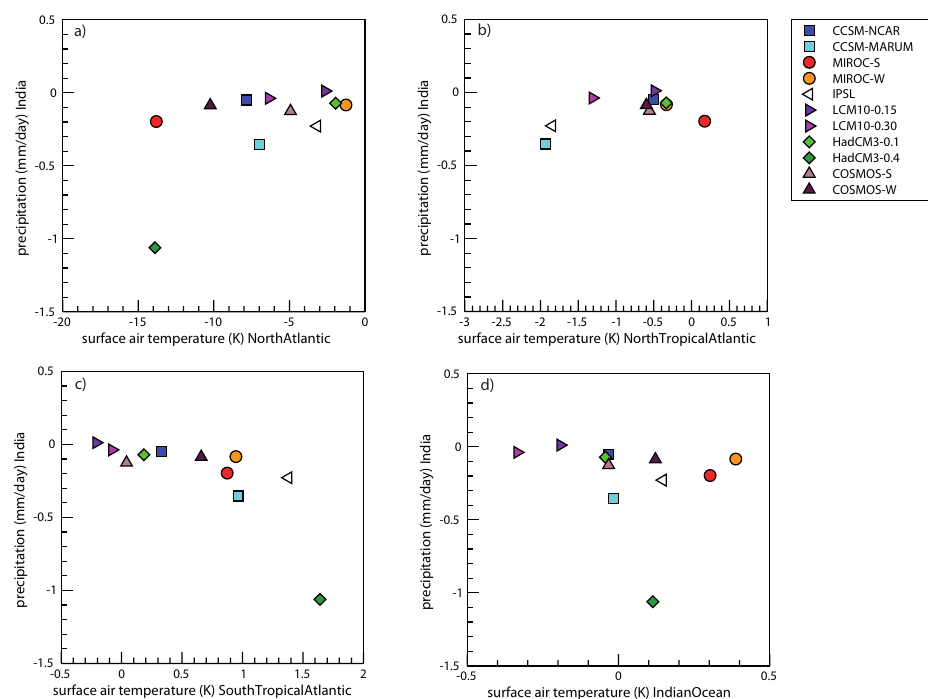
Fig. 10. Relationships involving precipitation changes over the Indian monsoon region, defined for latitudes ranging between 10 and 30 ◦ N and longitudes between 60 and 90 ◦ E; (a) with the NorthAtlantic temperatures, (b) with the NorthTropicalAtlantic temperatures, (c) with the SouthTropicalAtlantic temperature and (d) with the IndianOcean temperatures. The “IndianOcean” region is defined for latitudes ranging between 10 ◦ S and 15 ◦ N and longitudes between 50 and 100 ◦